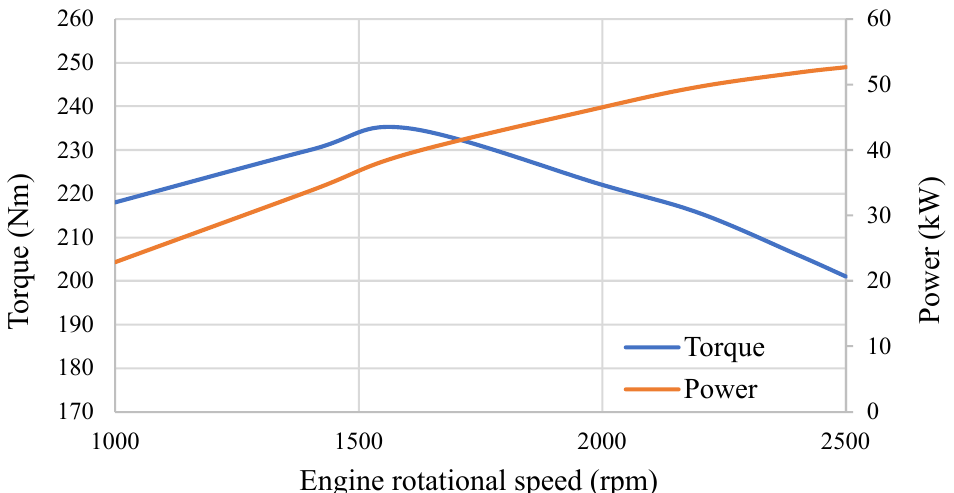
Figure 6. Downsized ICE torque and power curves.